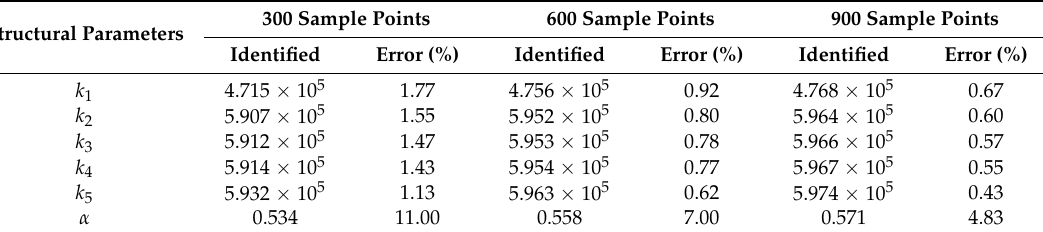
Table 2. Identified structural parameters with different numbers of sample points. Structural Parameters